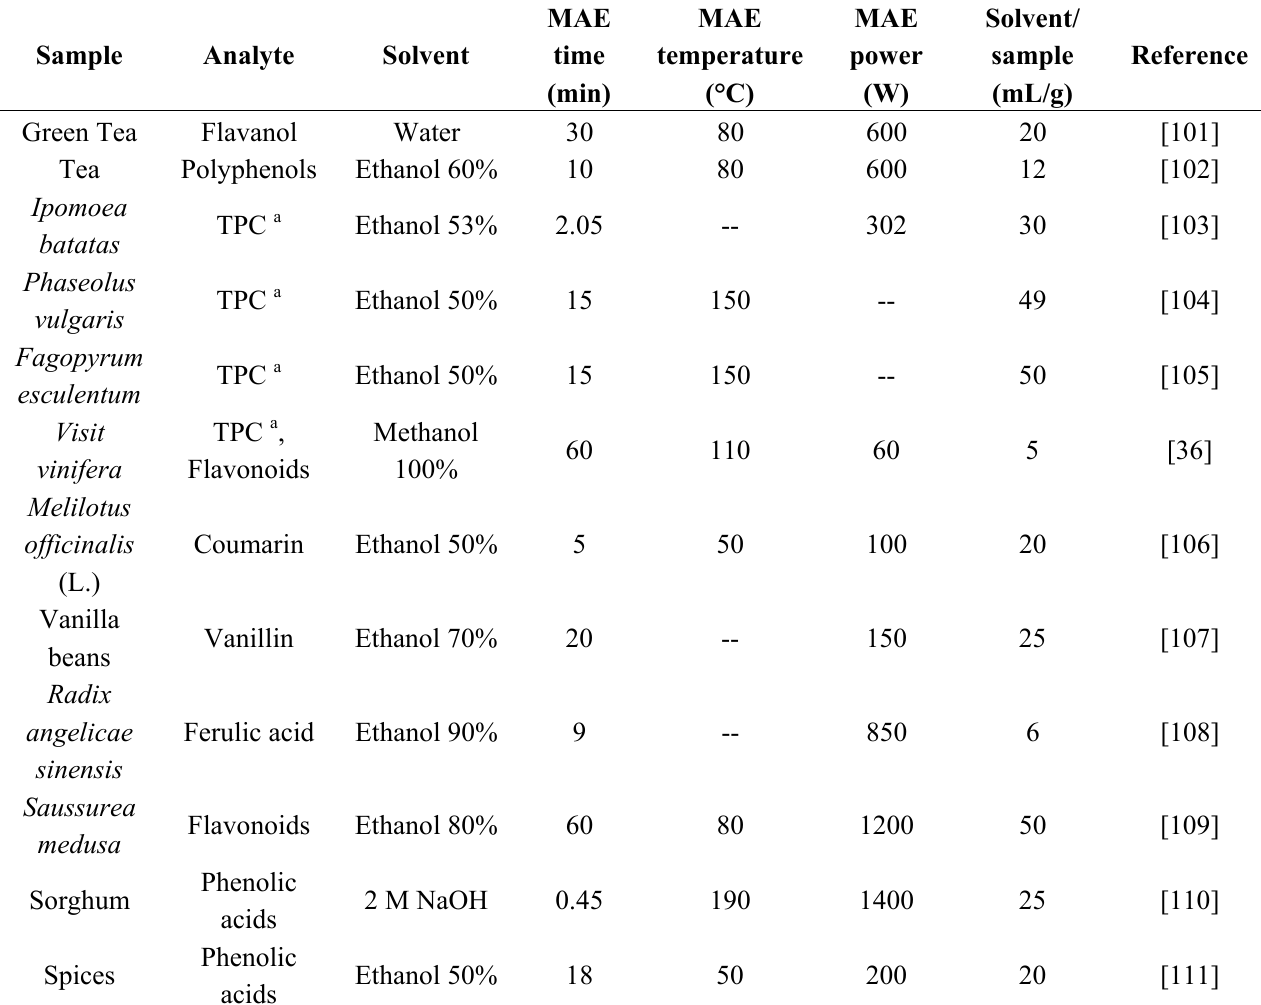
Table 3. Optimized conditions for phenolic extraction from plant-based foods using